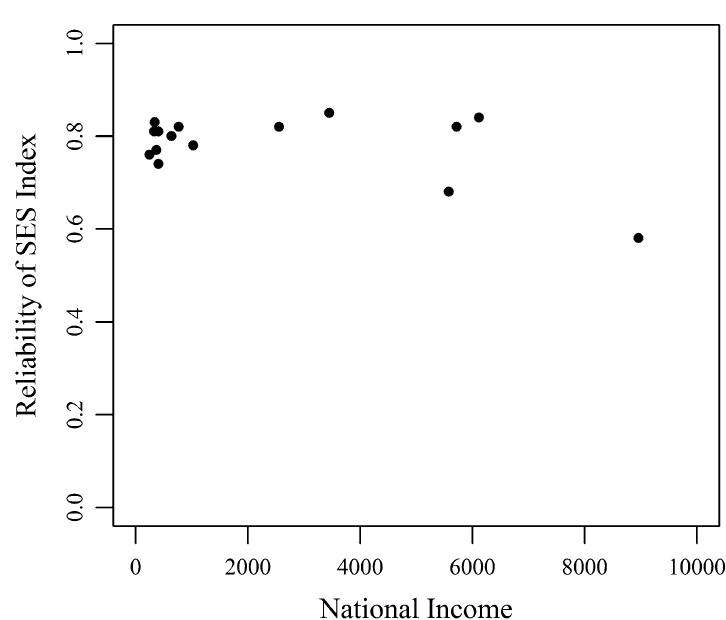
Fig. 1 National income and the reliability of the SES Index in SACMEQ III education